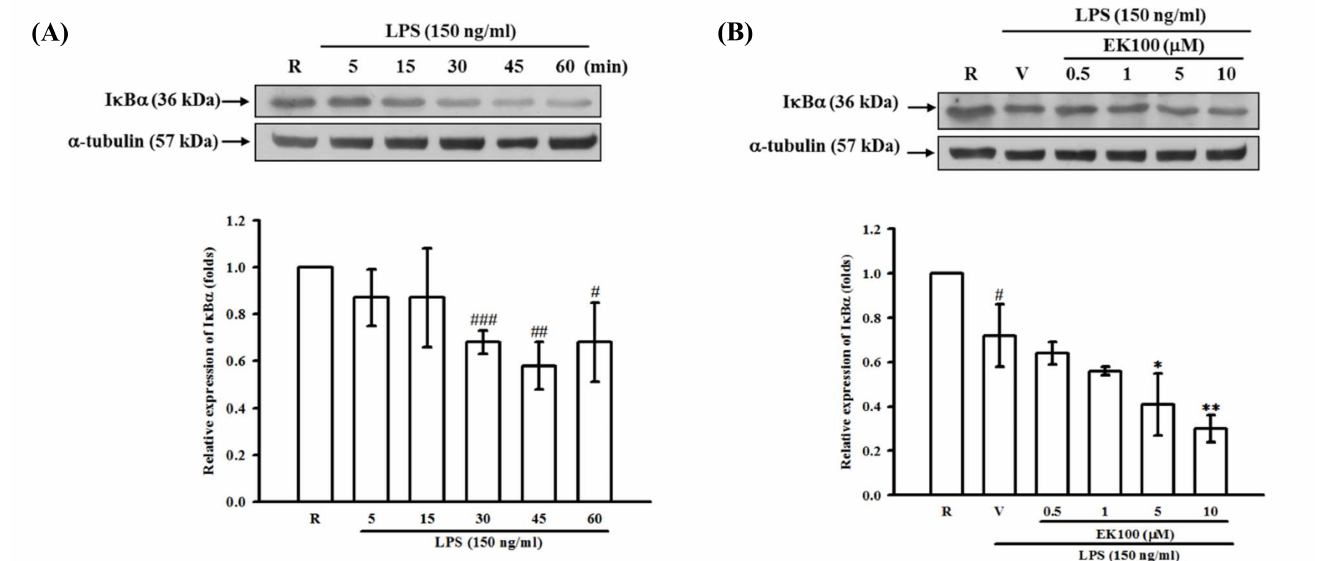
Figure 6. Effect of EK100 on the LPS-induced degradation of I κ B α in BV-2 cells. Western blot analyses were demonstrated ( A ) the time course of LPS-induced I κ B α degradation in BV-2 cells. The cells (2 × 10 5 cells/mL) were dispensed on 6-well plates and stimulated with LPS (150 ng/mL) for 5, 15, 30, 45, and 60 min as indicated, respectively. The data were shown as the mean ± SD ( n = 3). # p < 0.05, ## p < 0.01, ### p < 0.001 compared with the resting group (R). ( B ) BV-2 cells (2 × 10 5 cells/mL) were pretreated with EK100 (0.5, 1, 5 and 10 µ M) or vehicle (V) for 15 min and stimulated with LPS (150 ng/mL) for 45 min. The cell lysates were obtained and analyzed with a specific I κ B α antibody using Western blotting methods. The data were shown as the mean ± SD ( n = 3). # p < 0.05 compared with the resting group (R); * p < 0.05, ** p < 0.01 compared with the vehicle under